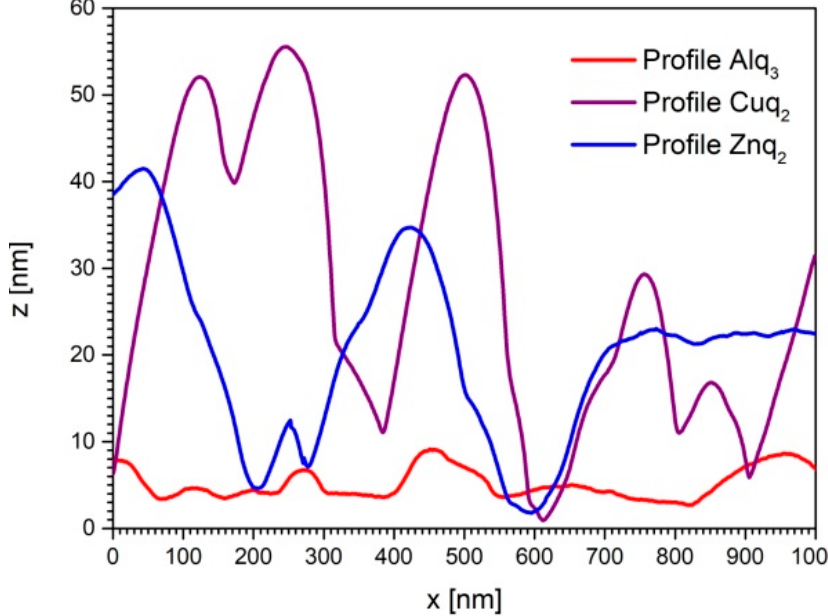
Figure 3. AFM profiles of investigated metalorganic complexes thin films.